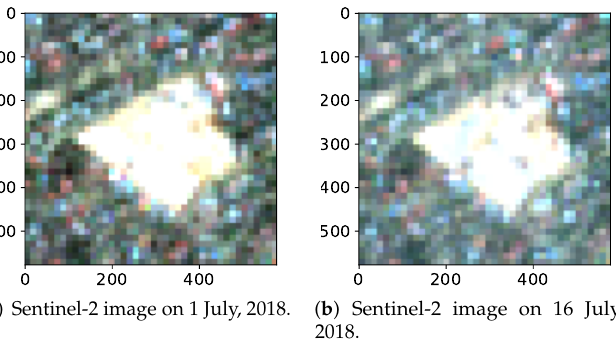
Figure 6. Sentinel-2 images of a true-positive blob of a construction site in